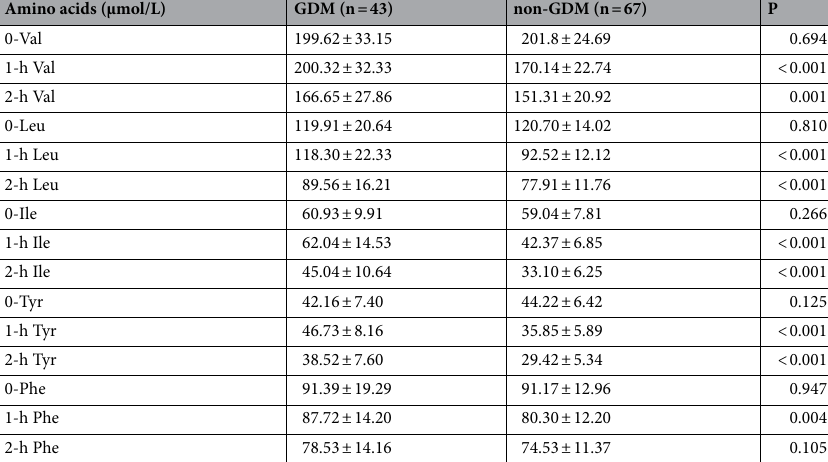
Table 2. Comparisons of serum amino acid concentrations in the non-gestational diabetes mellitus (non- GDM) and GDM during an oral glucose tolerance test (OGTT). Values were expressed as mean ± standard deviation. Comparisons between the non-gestational diabetes mellitus (non-GDM) and GDM groups were performed using student’s t-test. The statistically significant difference was defined as P < 0.05. Val valine, Leu leucine, Ile isoleucine, Tyr tyrosine, Phe phenylalanine, 0 fasting, 1-h one-hour at OGTT, 2-h two-hour at OGTT.